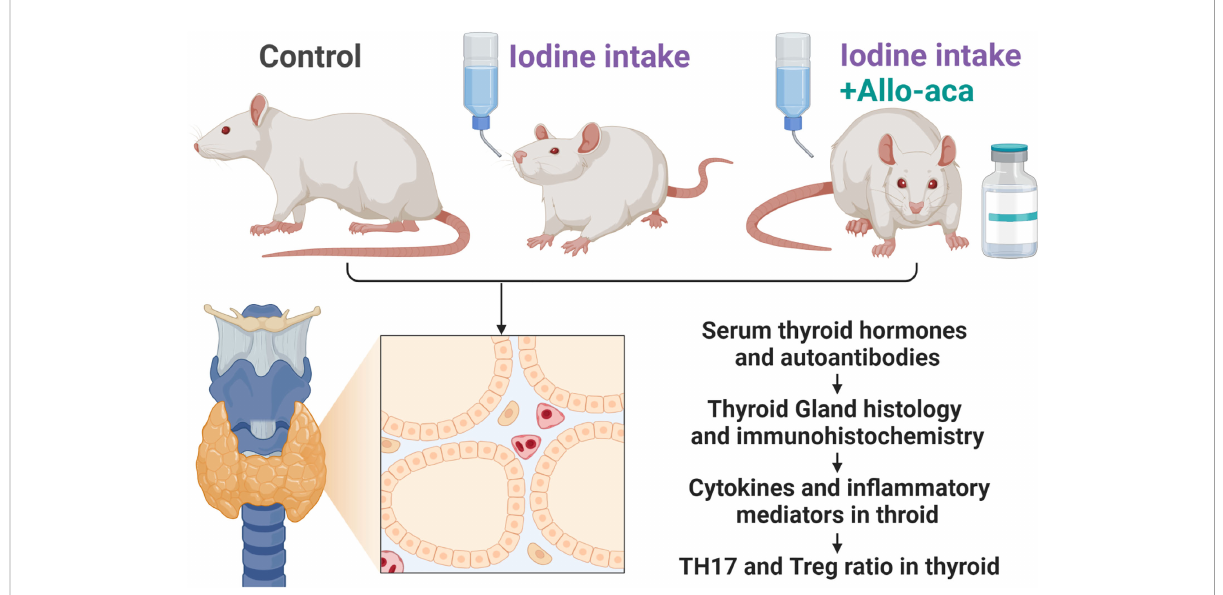
FIGURE 1 Experimental Procedure. NOD mice were divided into the control group, the experimental autoimmune thyroiditis (EAT) group and the Allo-aca treatment group. The EAT model was replicated by 0.05% iodine water intaking for 8 weeks. The Allo-aca treatment group received a subcutaneous injection of Allo-aca daily. The peripheral blood, thyroid and spleen of the experimental animals were used in the subsequent